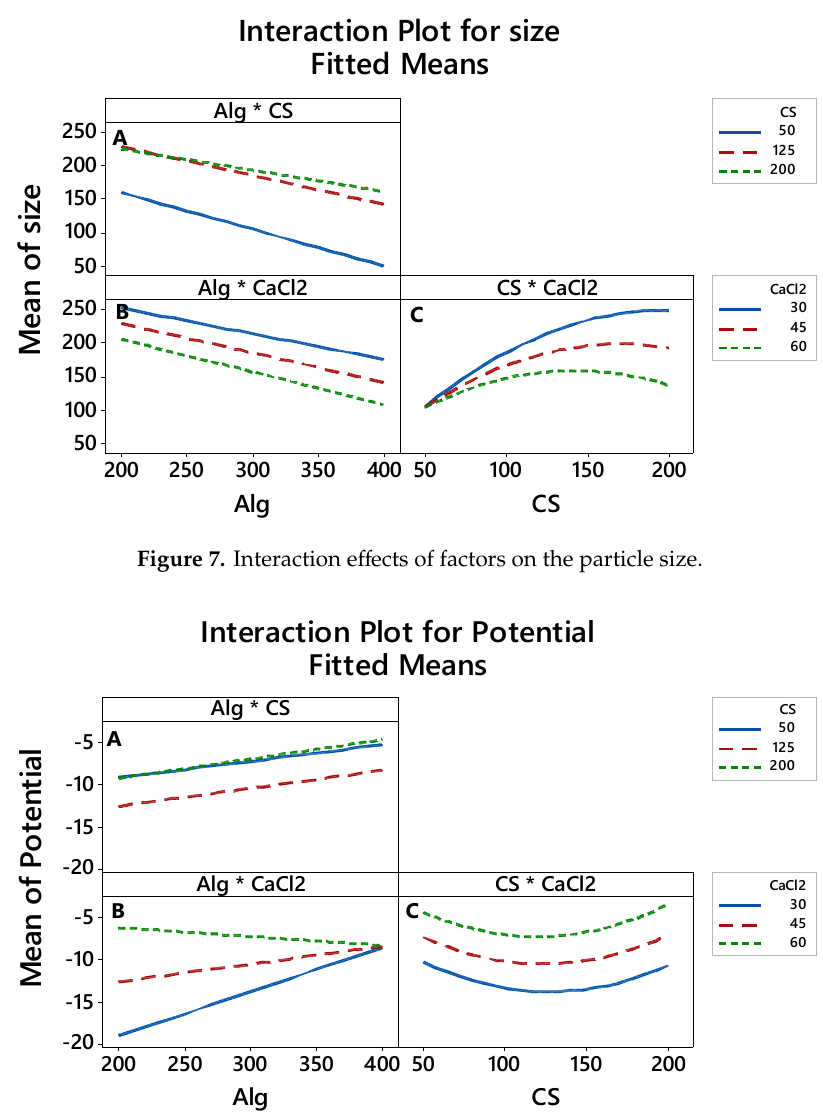
Figure 6. Interaction effects of factors on the loadingefficiency. 306